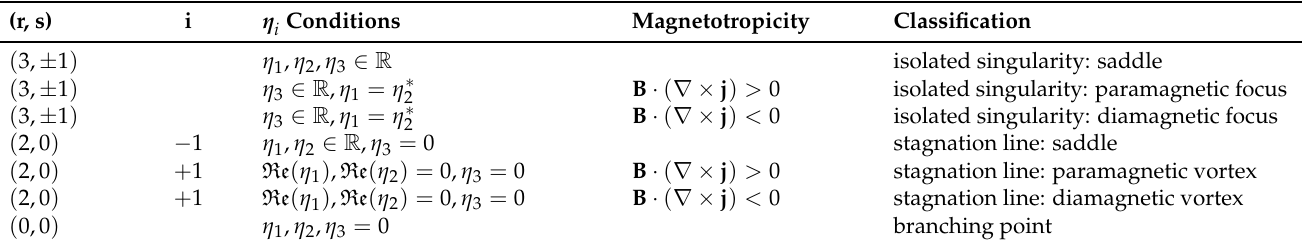
Table 1. The classification of stagnation points by their topological